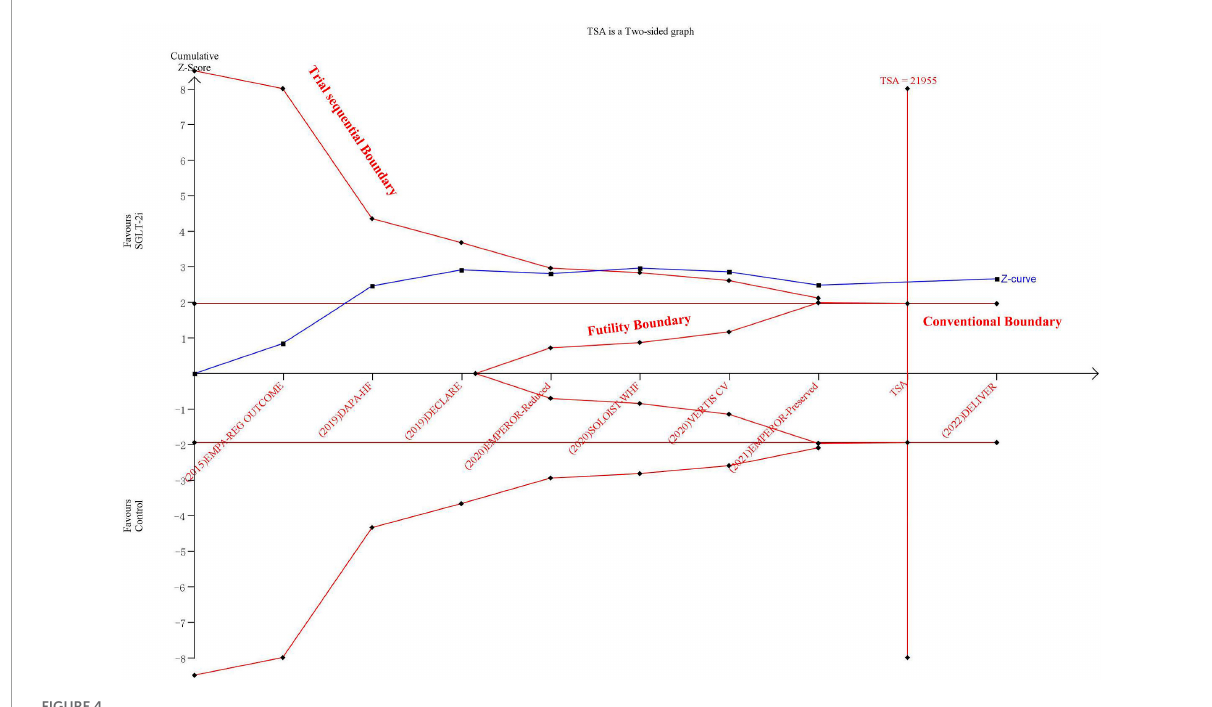
FIGURE4 The trial sequential analysis in terms of all-cause